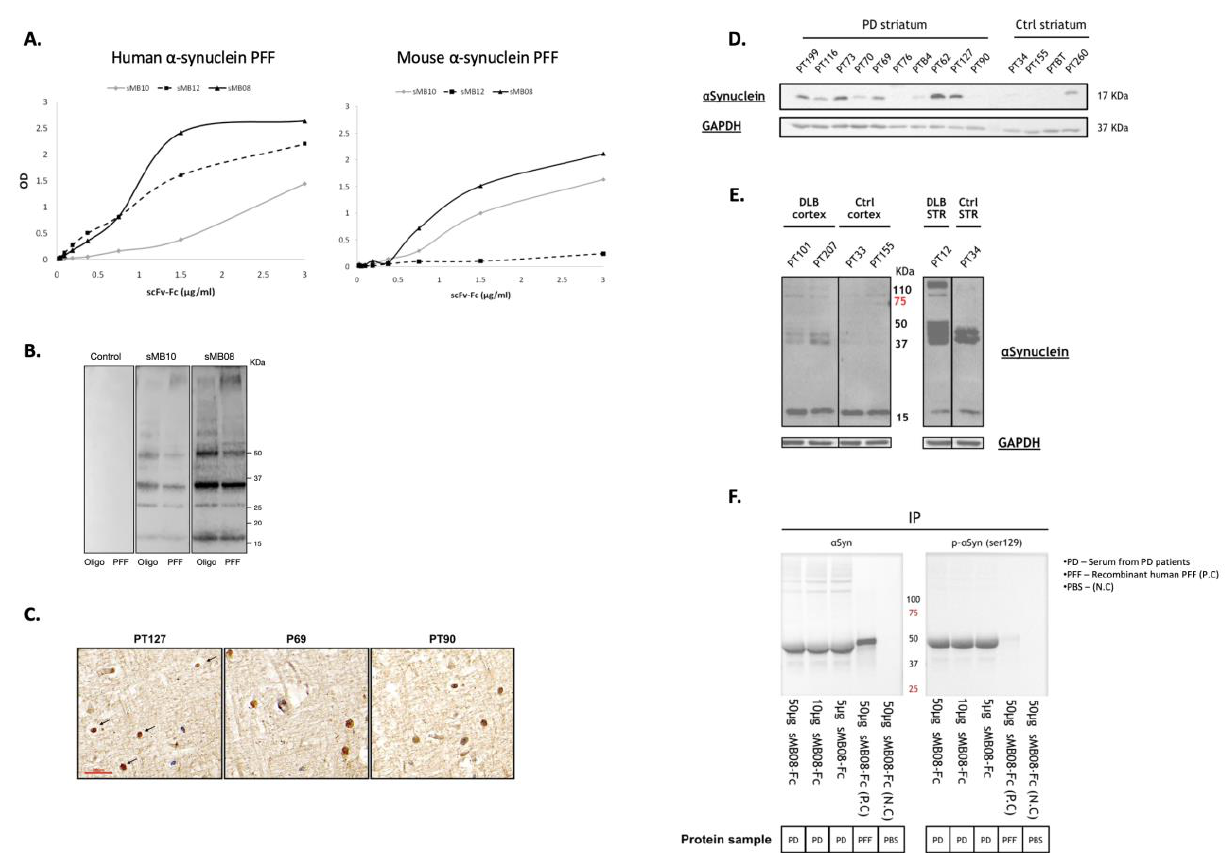
Figure 1. sMB08 selection, affinity and binding properties. ( A ) High affinity binding of scFv-Fc’s to human alpha synuclein PFF versus mouse alpha synuclein PFF in ELISA assay. ELISA results are in triplicates (technical sample repetition); ( B ) Western blots of scFv-Fc’s binding to human α Syn oligomers and PFF; ( C ) sMB08 recognizes α Syn Lewy bodies in the substantia nigra (PT127 and PT69) and cortex (PT90) of PD patients. Arrows indicate example of positive Lewy bodies. Data shown representative micrographs of substantia nigra and cortex sections from human brain of PD patients. Scale bar 30 µ m; ( D ) Western blots of sMB08 binding to human striatum extracts from PD/control group patients; ( E ) sMB08 binding to human cortex (left panels) and striatum (STR—right panels) extracts of DLB and control group (Ctrl) patients. GAPDH as “housekeeping” protein loading control is shown in lower panels; ( F ) sMB08 (scFv-Fc for immunoprecipitation) immunoprecipitates α Syn from PD patients sera. Left panel—human α Syn staining using mouse monoclonal anti-human α Syn antibody ( α Syn clone Syn 204); Right Panel—phosphorylated human α Syn staining using mouse monoclonal anti-human phosphorylated α Syn in serine 129 (P- α Syn